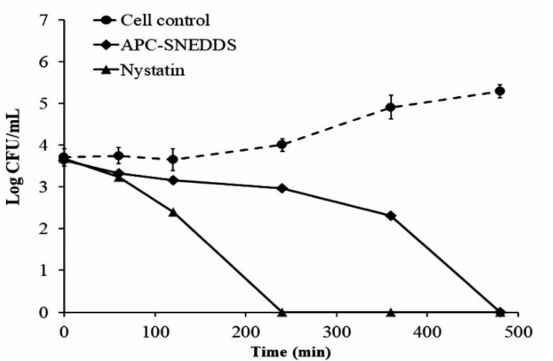
Figure 6. Killing kinetics curves of APC-SNEDDS and nystatin against C. albicans in comparison with control cells